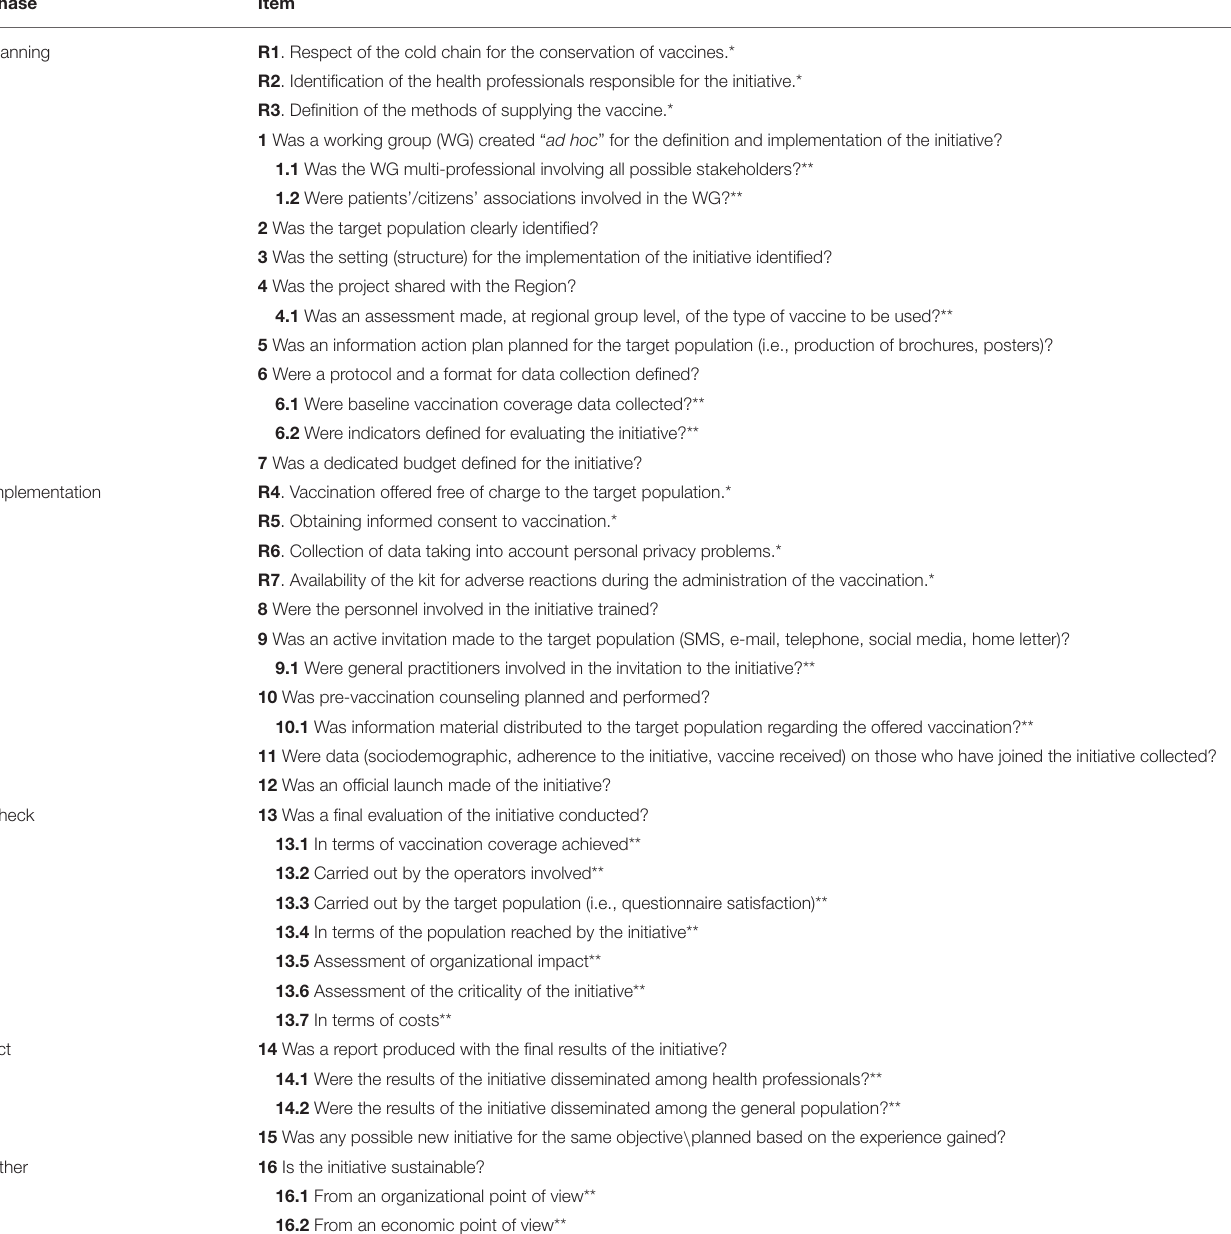
TABLE 3 | Final tool. Phase